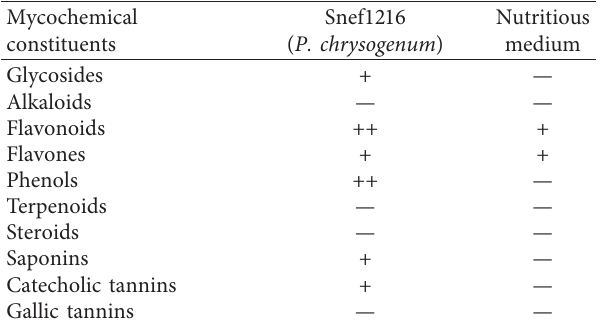
Table 1: Qualitative analysis of mycochemicals in the fermentation strain Snef1216 ( P. chrysogenum ) and nutritious